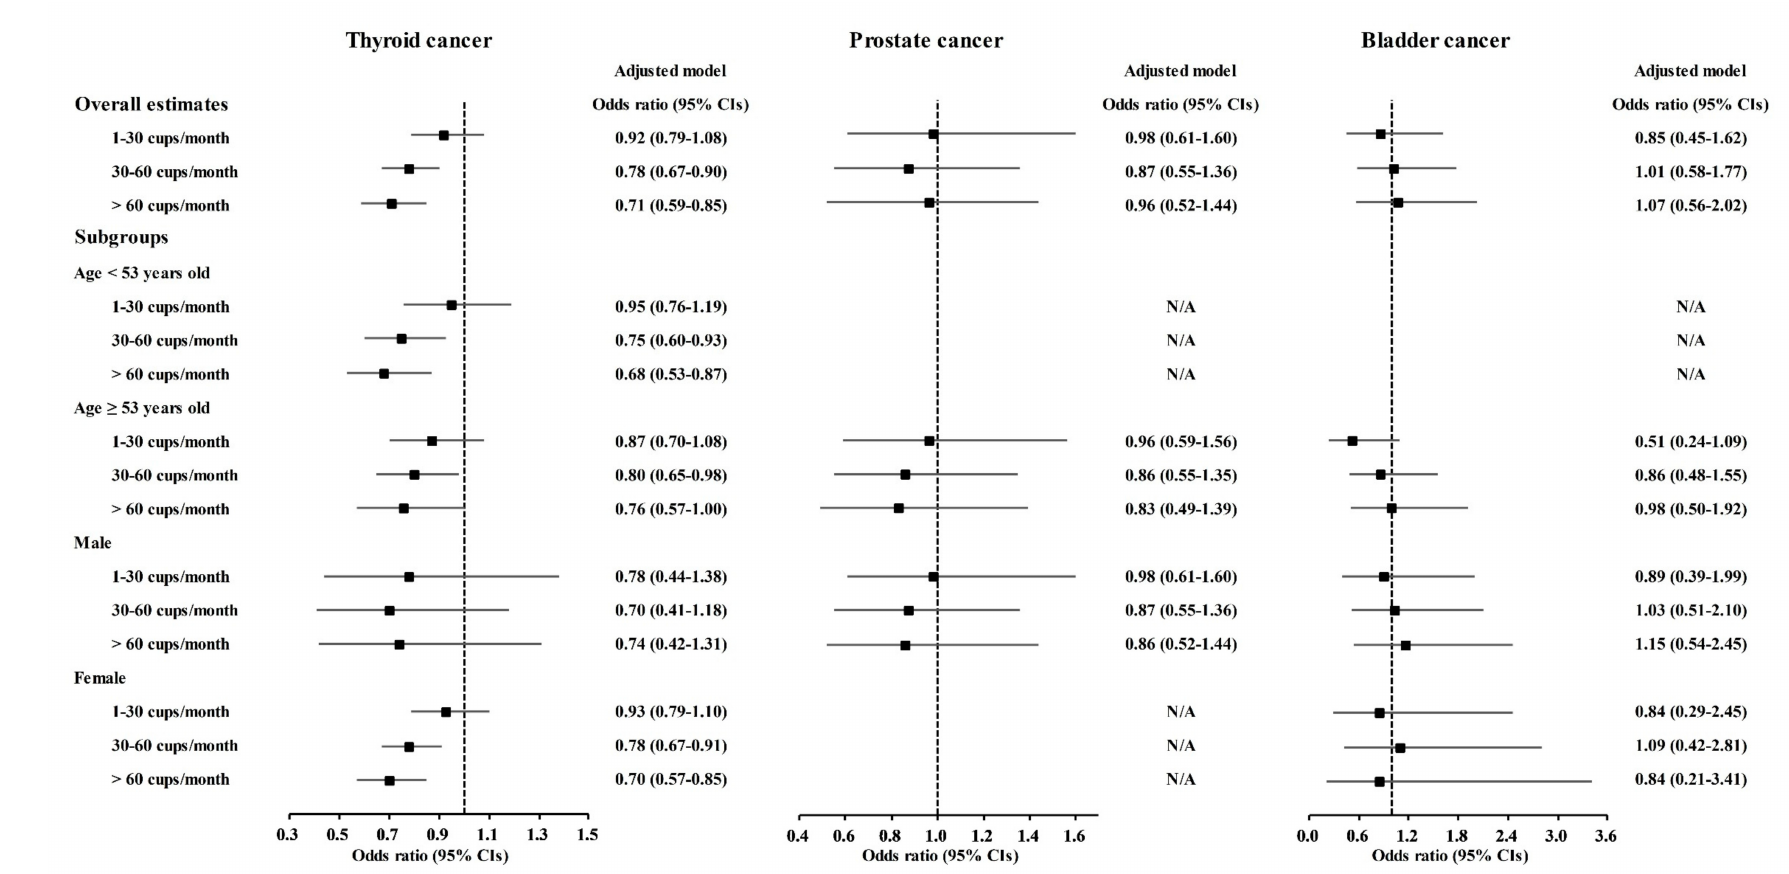
Figure 4. Odds ratios of coffee drinking habit for thyroid cancer, prostate cancer, and bladder cancer histories according to age and